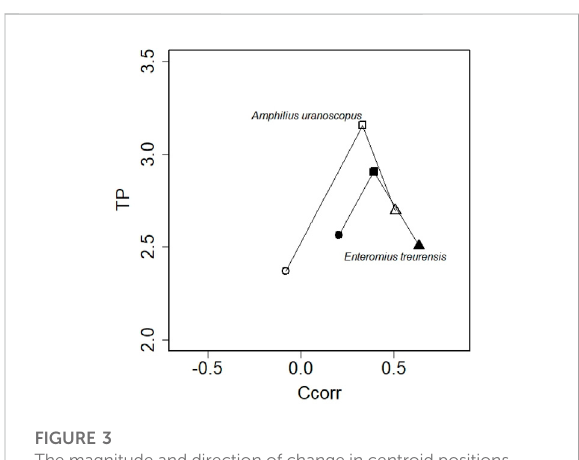
FIGURE 3 The magnitude and direction of change in centroid positions of Enteromius treurensis and Amphilius uranoscopus across invaded and uninvaded sites on the Blyde and Treur rivers in Mpumalanga Province, South Africa.